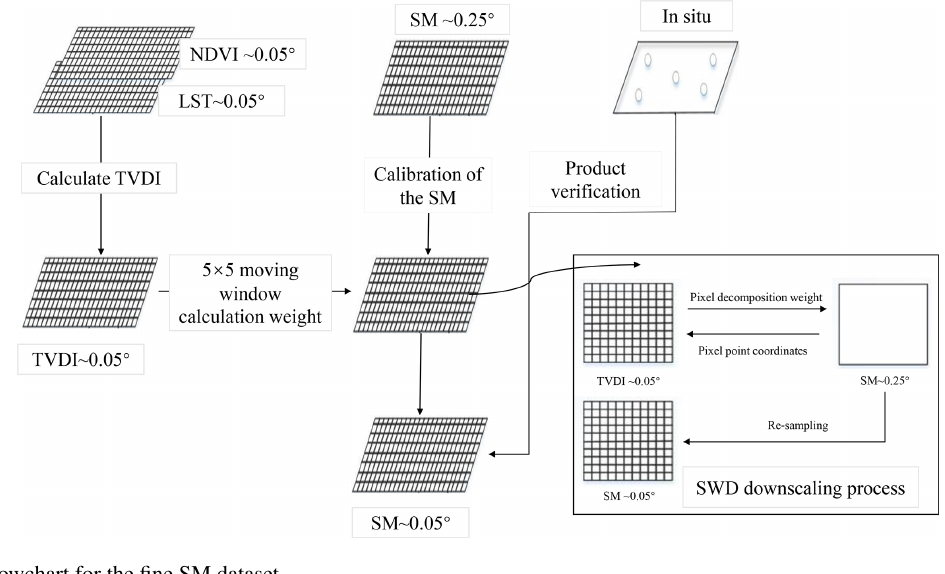
Figure 2. The flowchart for the fine SM dataset.